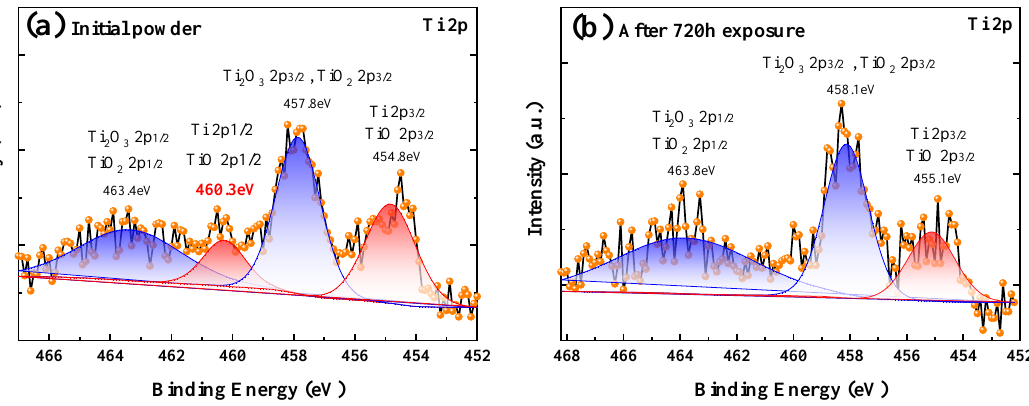
Figure 7. The oxidation state of titanium on the surface of ( a ) initial powder, and ( b ) the powder after 720 h exposure.